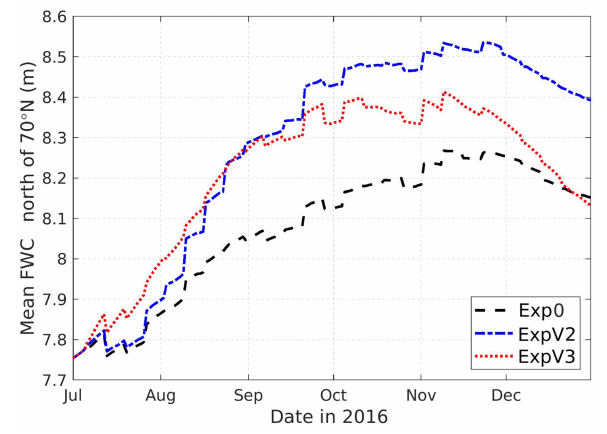
Figure 11. Arctic-wide averaged freshwater content (unit: m) in the central Arctic ( > 70 ◦ N) from July to December 2016 for Exp0 (dashed dark), ExpV2 (dashed blue), and ExpV3 (dotted